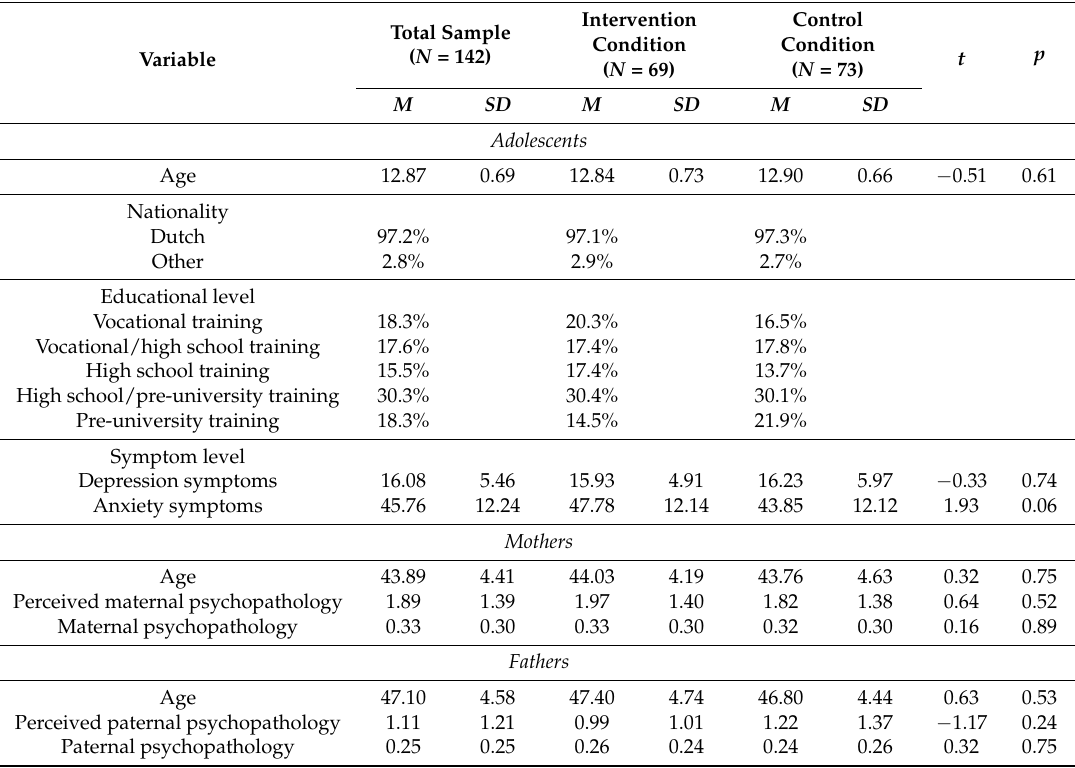
Table 1. Baseline